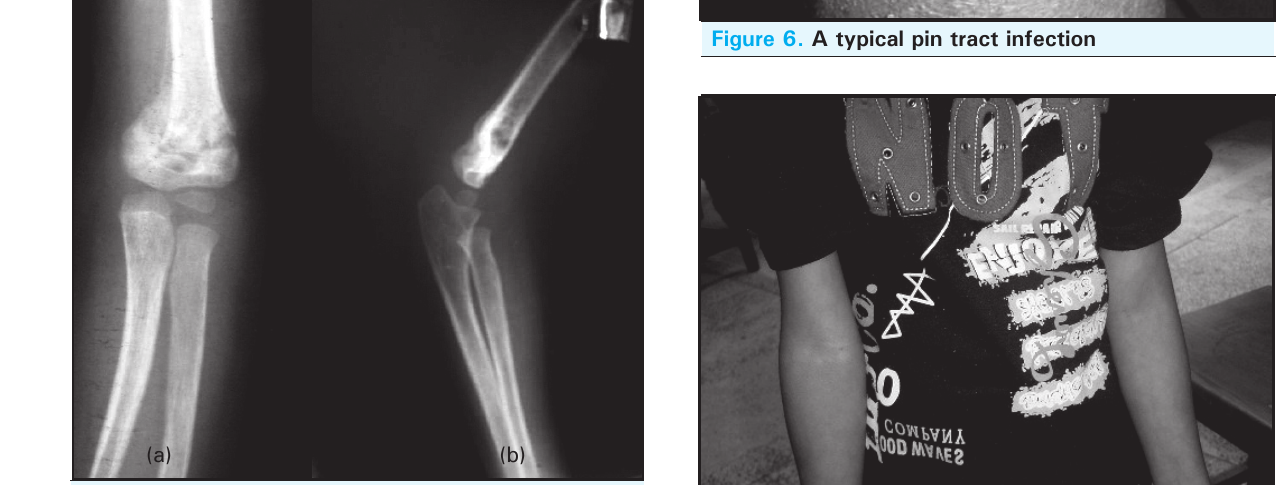
Figure 4. good union seen after k-wire removal (a) anterior-posterior (AP) and (b) lateral view on the eighth week post-operatively